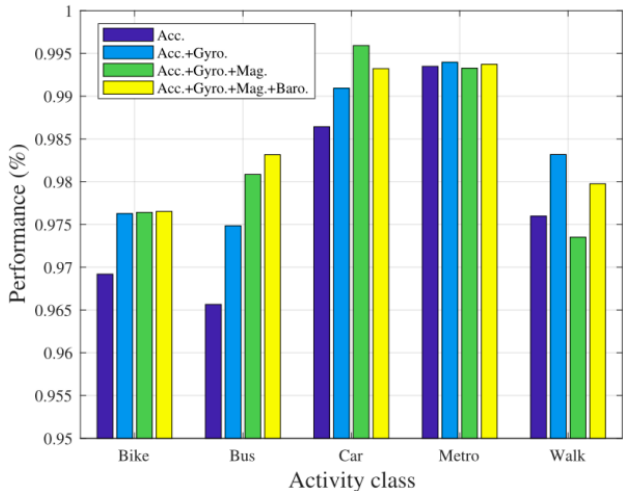
Figure 7. The performance of different travel modes with different sensor combinations.